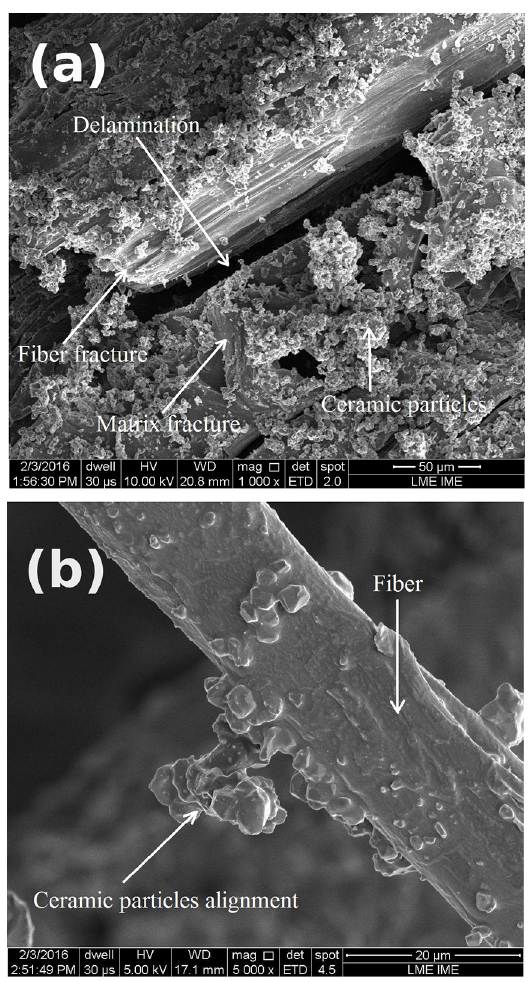
Figure 4. SEM micrographs of the fracture surface of the composites covered with ceramic fragments: (a) 1000x; (b) 5000x.